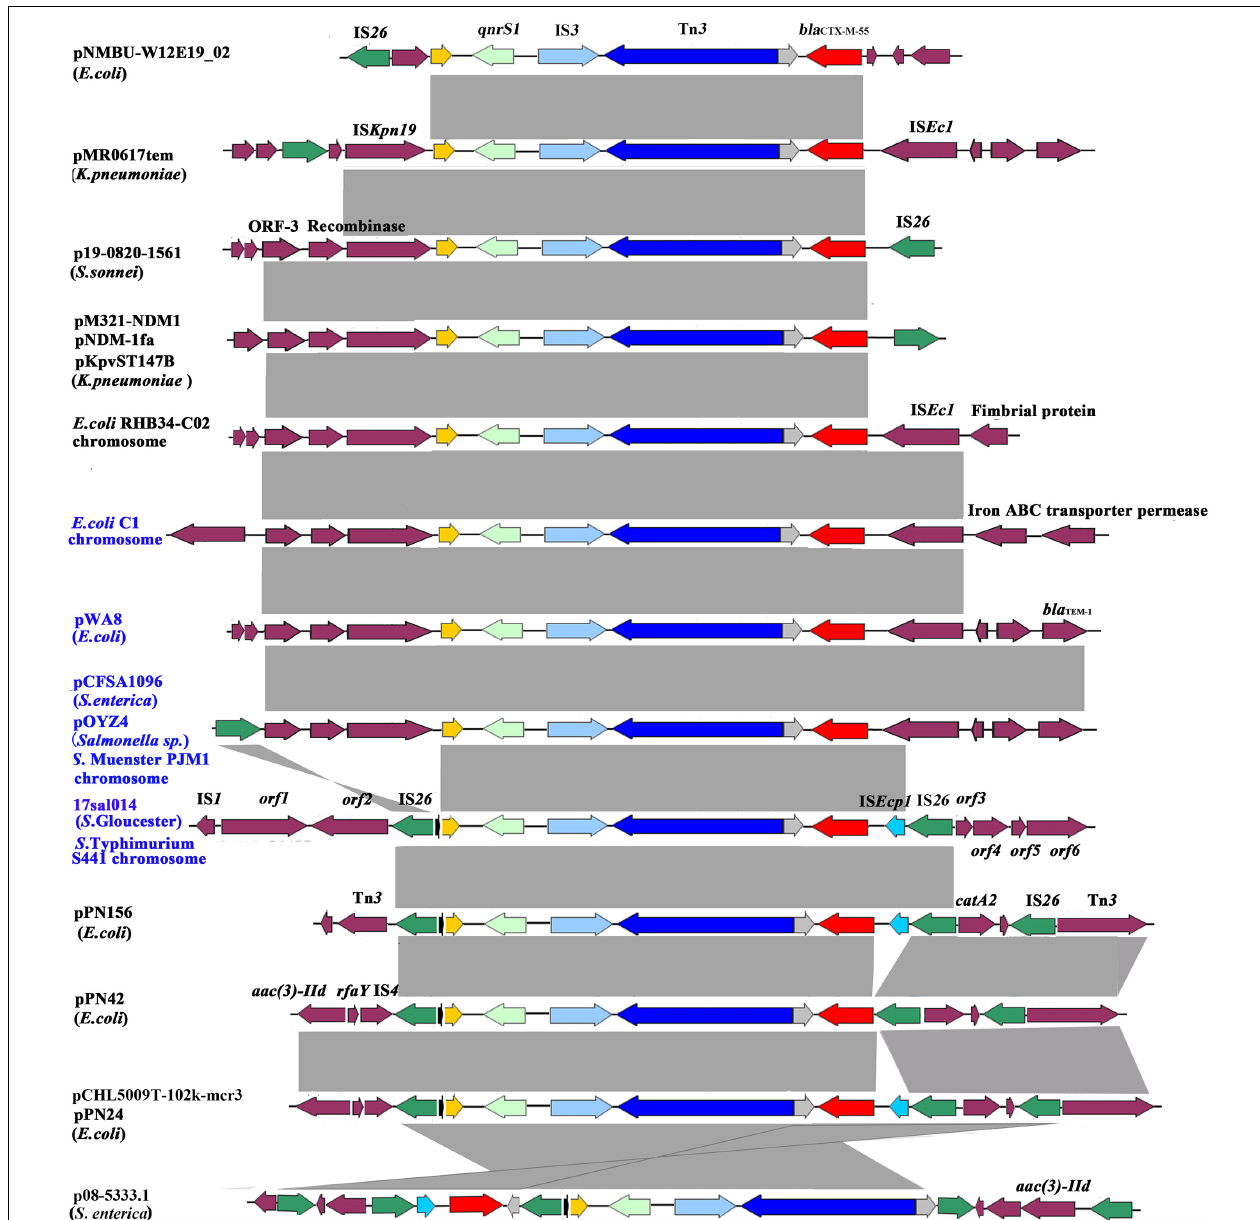
FIGURE 1 | Genetic environment of the bla CTX − M − 55 and qnrS1 genes from the Salmonella Gloucester isolate 17Sal014 and bacterial species from different regions. The arrows indicate open reading frames. Light gray shading denotes homology regions. The orf1 – orf6 genes encode DNA cytosine methyltransferase, type II site-specific deoxyribonuclease, hypothetical protein, 3 (cid:48) –5 (cid:48) exoribonuclease, DUF4224 domain-containing protein, and tyrosine-type recombinase/integrase, respectively. Strains from China are in blue